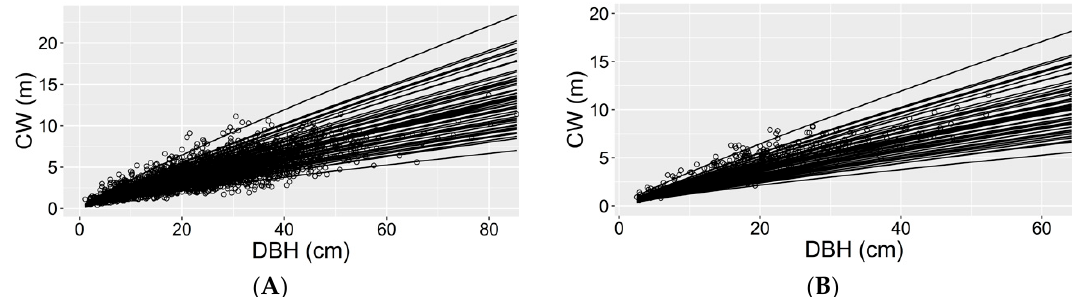
Figure 3. Localized curves of simple mixed model (MM2) based on four randomly selected trees overlaid on the fitting data ( A ) and on validation data ( B ).